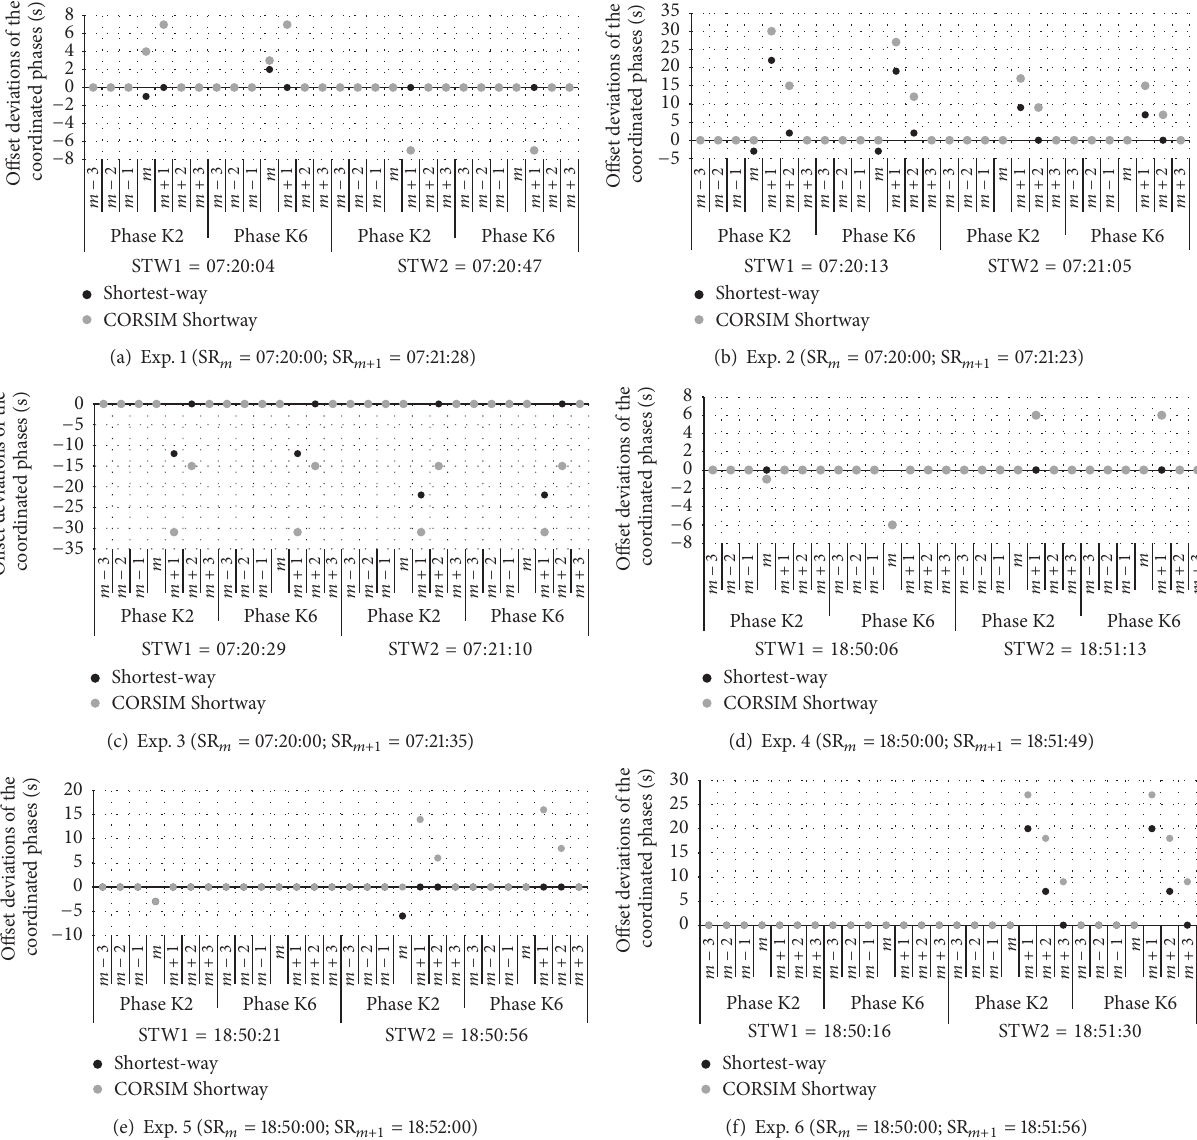
(b) Exp. 2 ( SR 𝑚 = 07:20:00; SR 𝑚+1 = 07:21:23)